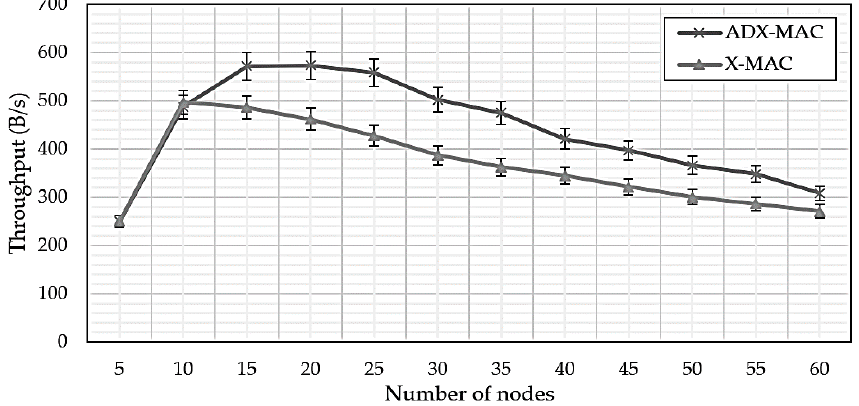
Figure 7. ADX-MAC and X-MAC throughput.